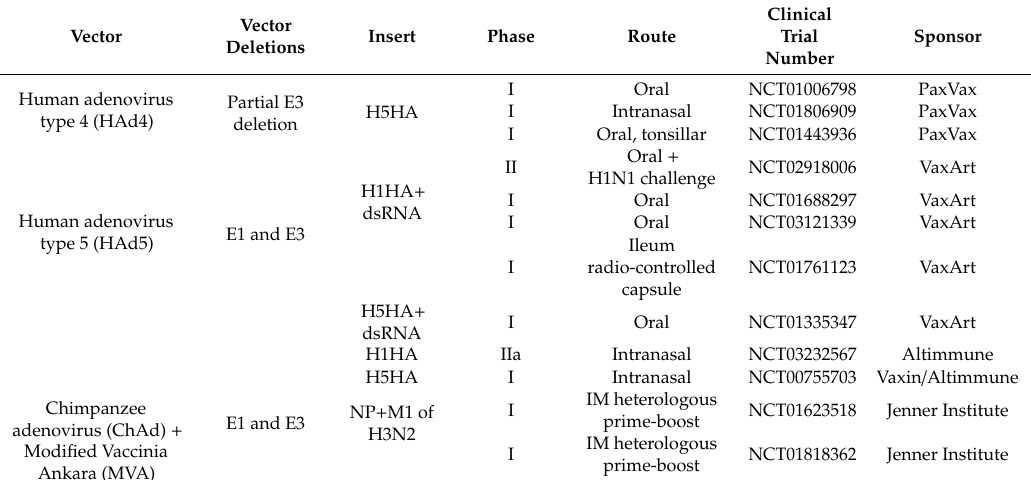
Table 2. Adenovirus vector-based influenza vaccines in clinical